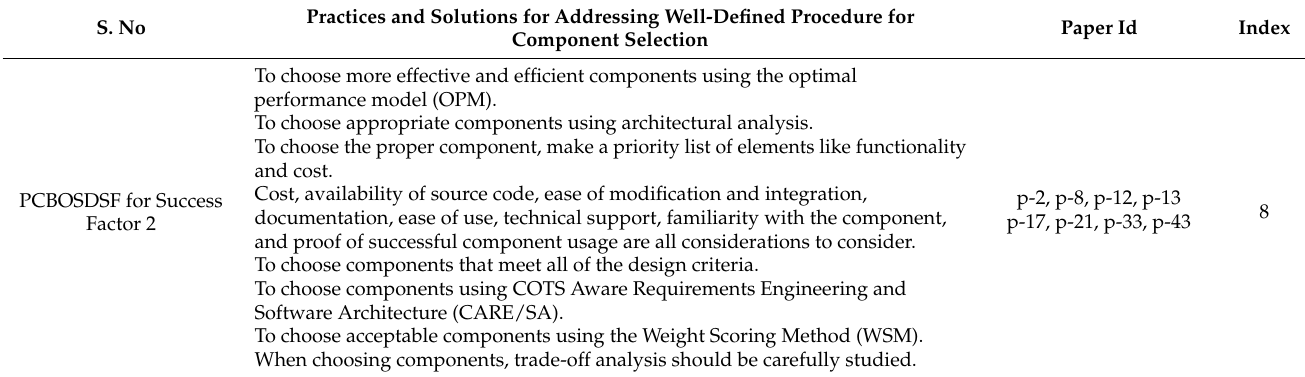
Table 6. CBOSDSF 2: Well-defined procedure for component selection.